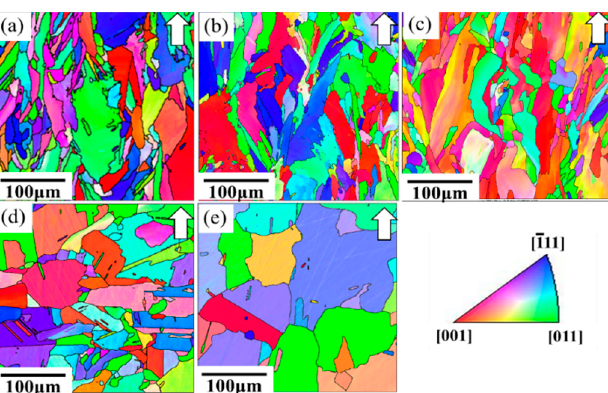
Figure 4. Scanning electron microscope images of ( a ) as-built, ( b ) STA-980 °C, ( c ) STA-1045 °C, ( d ) STA-1065 °C, ( e ) STA-1120 °C, and ( f ) STA-1180 °C/1 h specimens.